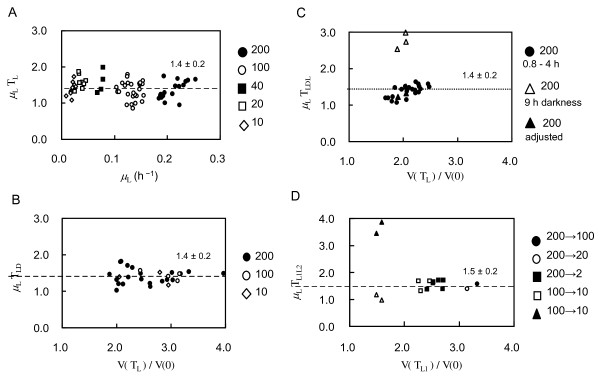
Product of the rate of cell volume increase and the duration of interdivision phase measured under different illumination conditions. A: LL conditions. Light intensities are as indicated (PAR values are in m-2 s-1). B: LD conditions. Light intensities are as indicated (PAR values are in m-2 s-1). C: LDL conditions. PAR was 200 μmol m-2 s-1 in all cases. Various light exposure patterns were used, the duration of the dark periods ranged from 0.8 to 4.0 hours (filled circles), and 9.0 hours (three open triangles). If the value of TLD is adjusted by subtracting the time cells spent in the dark (TD), the product of μLTLL, which is equal to μL(TLDL - TD), becomes approximately equal to 1.4 (three filled triangles) where TLL is the sum of first and second light period duration. D: L1L2 conditions. The intensities of light exposure were lowered (from 200 to 100, 200 to 20, 200 to 2, and 100 to 10 μmol m-2 s-1) at various times. For all ratios V(TL1)/V(0) < 2, the product of μL1TL1L2 increased far beyond 1.5 (two filled triangles). If we substitute μL1TL1L2 with μLTL1 + μL2TL2, the value becomes near to 1.5 (two open triangles) where μL2 is the rate of the volume increase during the second light period and TL2 is the duration of the second light period.